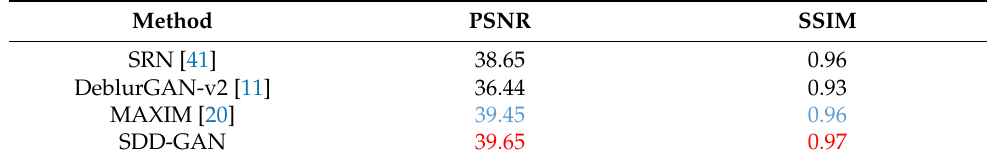
Table 4. Mean PSNR and SSIM for different deblurring methods on the RealBlur-R dataset. The highest scores are highlighted in red, and the second highest scores are highlighted in blue.